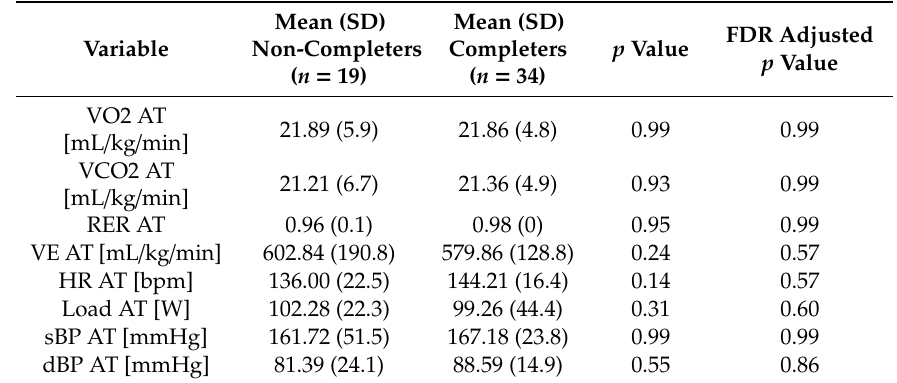
Table 4. Comparison of completers vs. non-completers before SEP in cardiopulmonary exercise test (CPET) parameters during